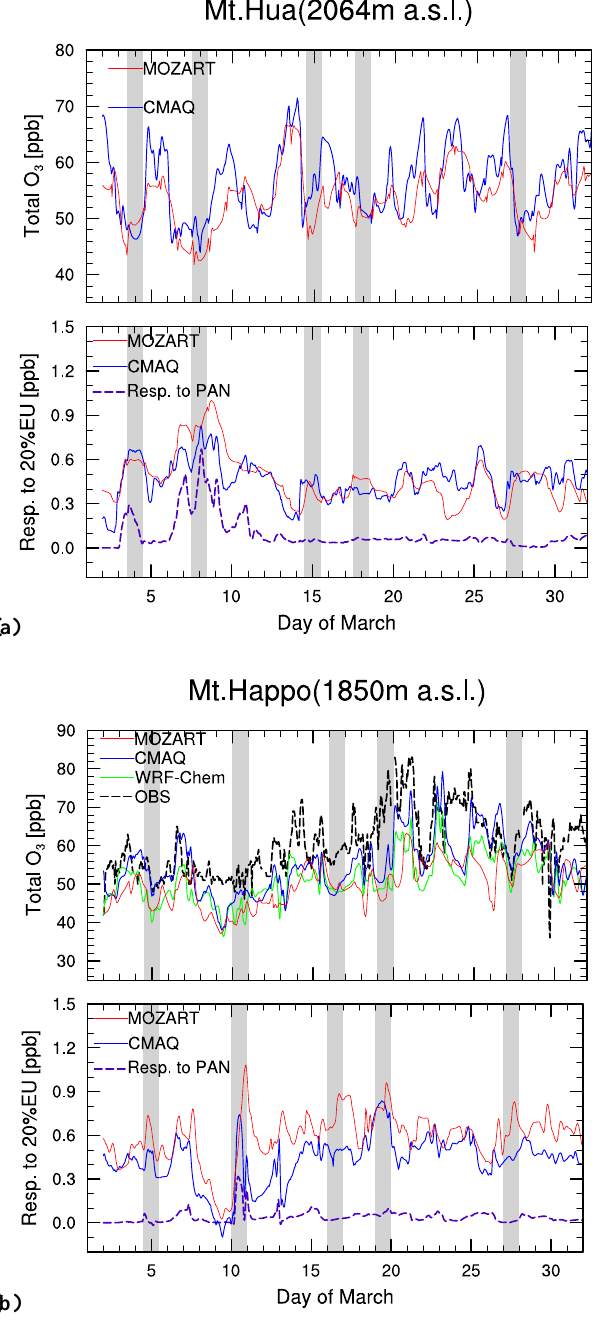
Figure 8b. Day-to-day variability of observed and calculated total O 3 at Mount Happo in central Japan and its response to a 20% reduction in European emissions. Fig. 8. (a) Day-to-day variability of calculated total O 3 at Mount Hua in central China and Mount Happo in central Japan, and the response to a 20% emission reduction in Europe. WRF-Chem cal- culated total O 3 and the observations available from the EANET are also shown for Mount Happo. The model results are sampled at the pressure altitude of the mountain sites. The dash purple line repre- sents the contribution of O 3 production driven by PAN decomposi- tion. The shaded bands indicate the timing of cold frontal passages.